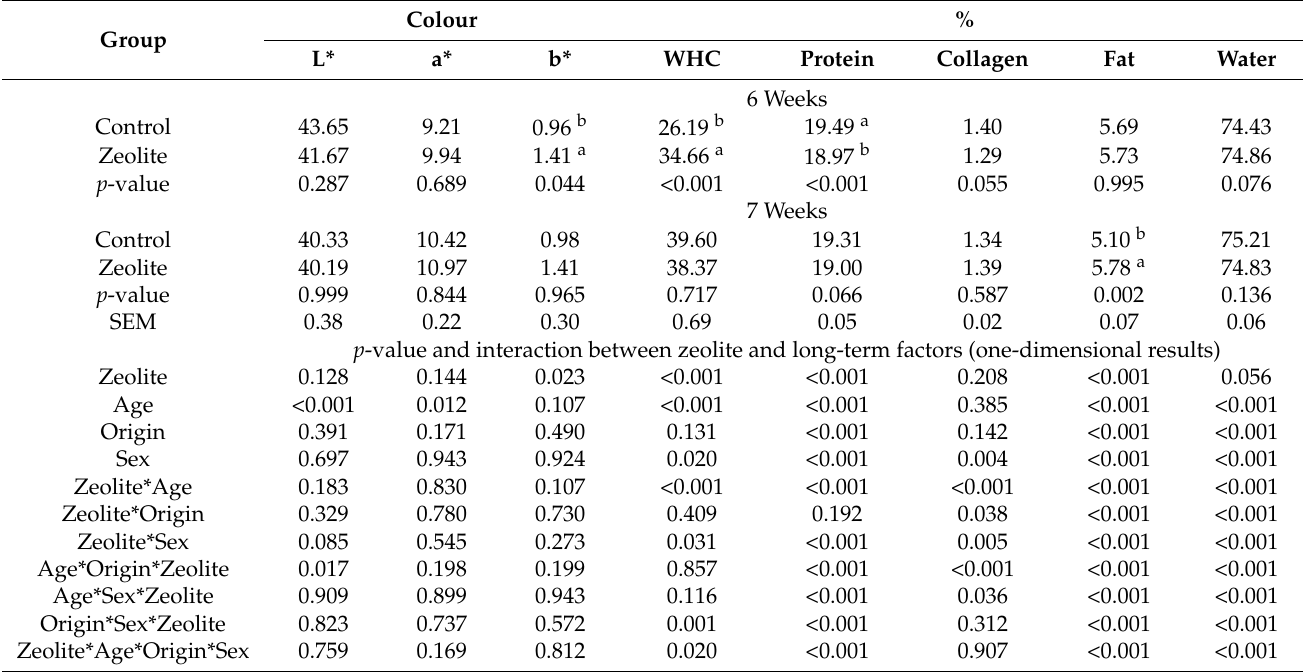
Table 7. Physicochemical parameters of leg muscles from broiler ducks